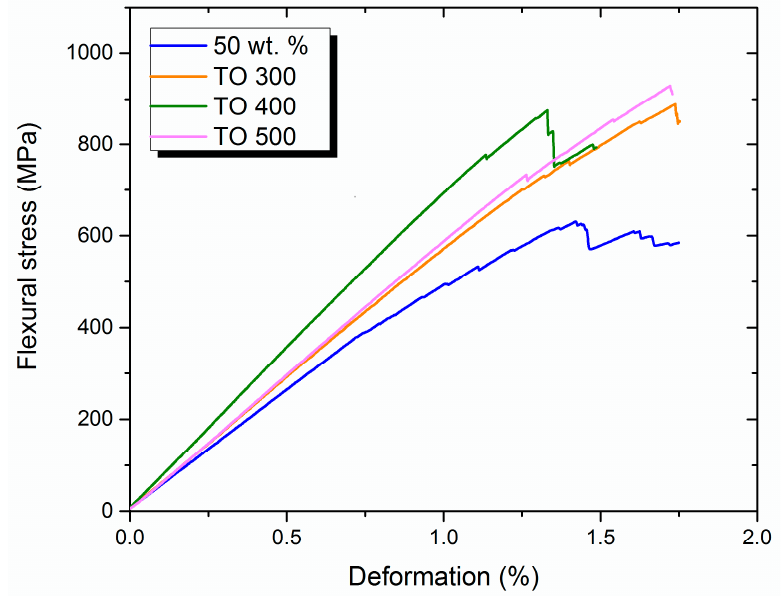
Figure 7. Typical stress–strain curves of 50/50 composites reinforced with modified carbon fibers during three-point bending test. during three-point bending test.